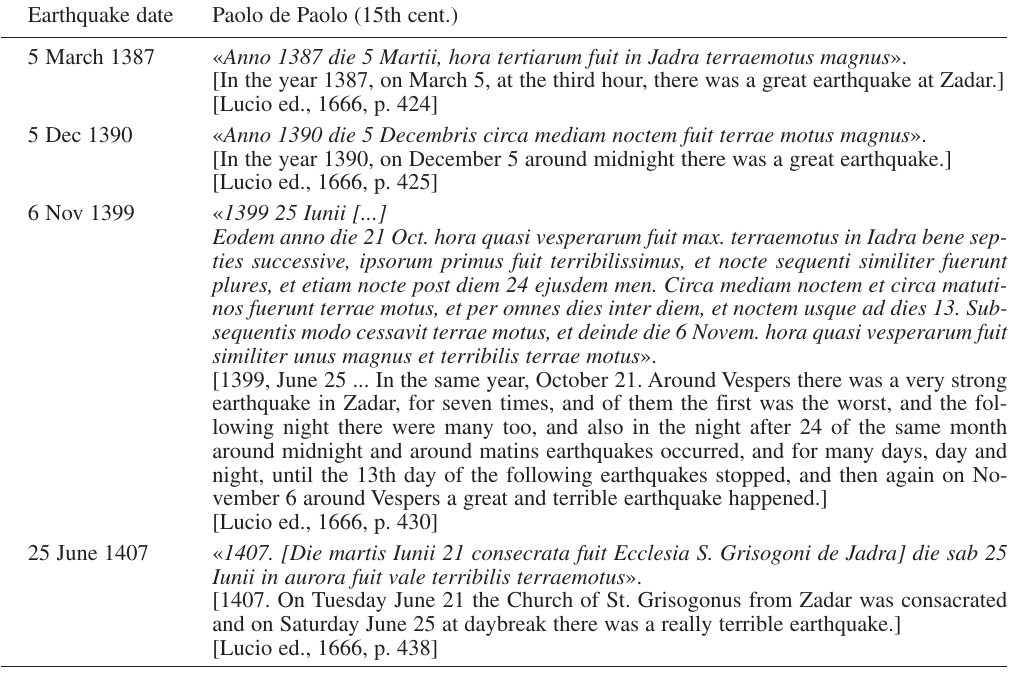
Table II. Records on earthquakes at Zadar between 1387 and 1407. Earthquake date Paolo de Paolo (15th